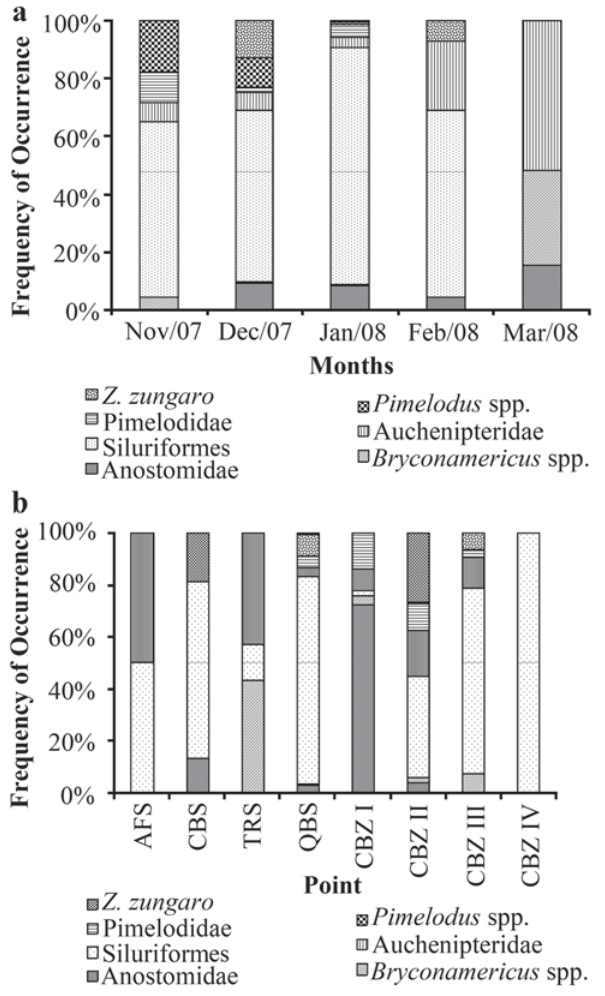
Fig. 6. Temporal ( a ) and spatial ( b ) frequency of occurrence of the seven most abundant taxa of fish larvae captured in the headwaters of the Cuiabá River between November 2007 and March